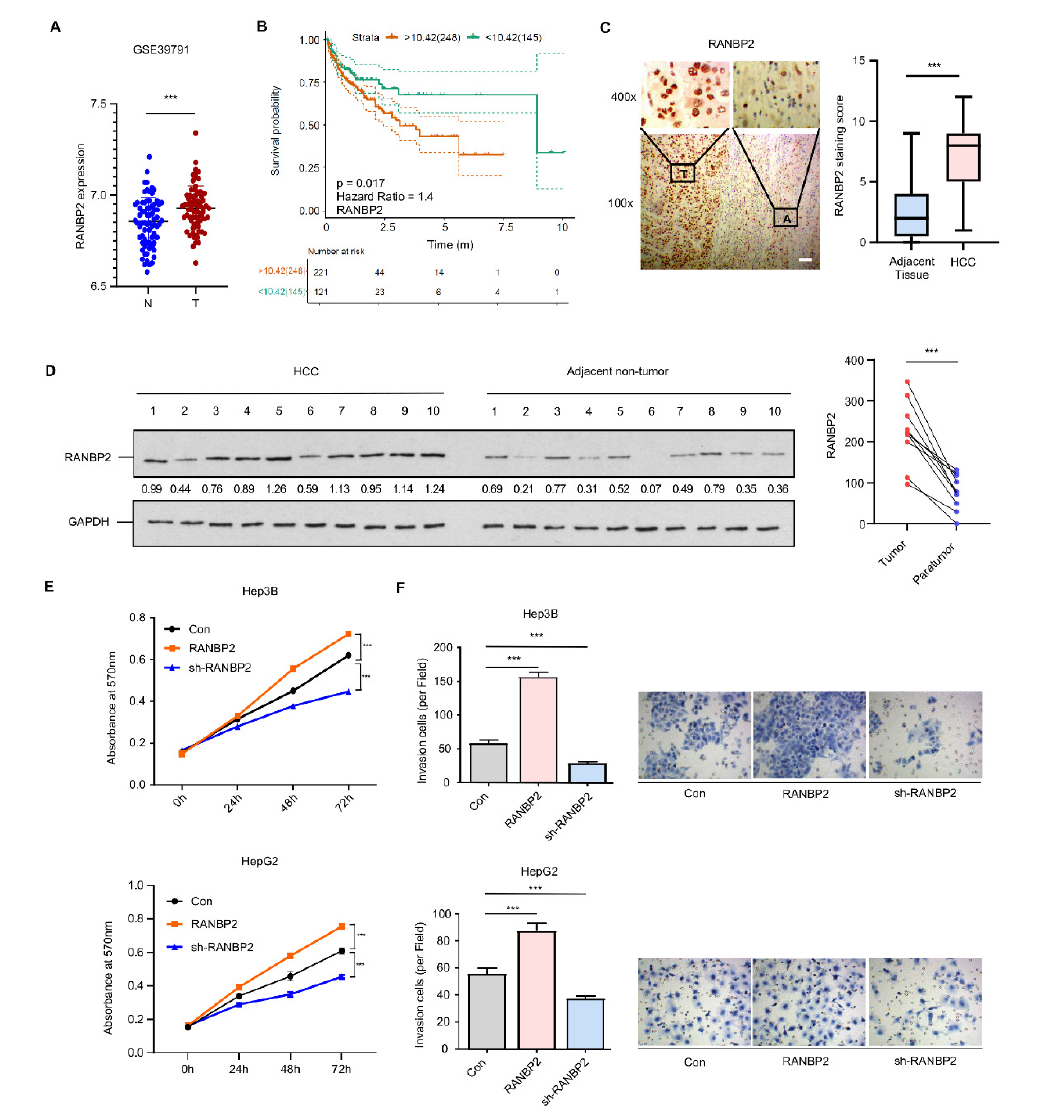
Figure 1. RANBP2 is enriched in HCC and correlates with malignant phenotypes. ( A ) RANBP2 mRNA level comparison between HCC and adjacent non-tumor tissue from the GEO databases. *** p < 0.001, t -test. ( B ) Survival curve from the GEPIA database indicates that RANBP2 was significantly associated with lower survival rate in HCC patients. The expressional tendency and clinical prognosis of RANBP2 in HCC are further shown in Supplementary Figure S1. ( C ) Immunohistochemical staining of RANBP2 in HCC tissue and matching adjacent non-tumor tissue. Left panel: Representative images (from total of 54 clinical samples) encompassing the border of tumor and non-tumor tissues. Right panel: Quantification of RANBP2 staining scores in box-and-whisker plot (plot: min to max). T = tumor tissue; A = adjacent non-neoplastic liver tissue. Scale bars, 20 µm. *** p < 0.001, χ 2 test. ( D ) Western blotting of RANBP2 in HCC tissue and matching non-neoplastic tissue. The paired gray values are shown in the right panel; n = 10 patients. ( E , F ) Cell viability ( E ) and invasion ( F ) in response to altered RANBP2. CCK-8 assay was conducted after 24, 48, and 72 h. The invasion ability was determined by Transwell assay. Hep3B and HepG2 cells were transfected with a RANBP2-overexpressing vector and targeting shRNAs. Data are presented as the mean ± SD values from three biological replicates. *** p < 0.001, t -test. RANBP2 knockdown efficiency is shown in Supplementary Figure S2A.